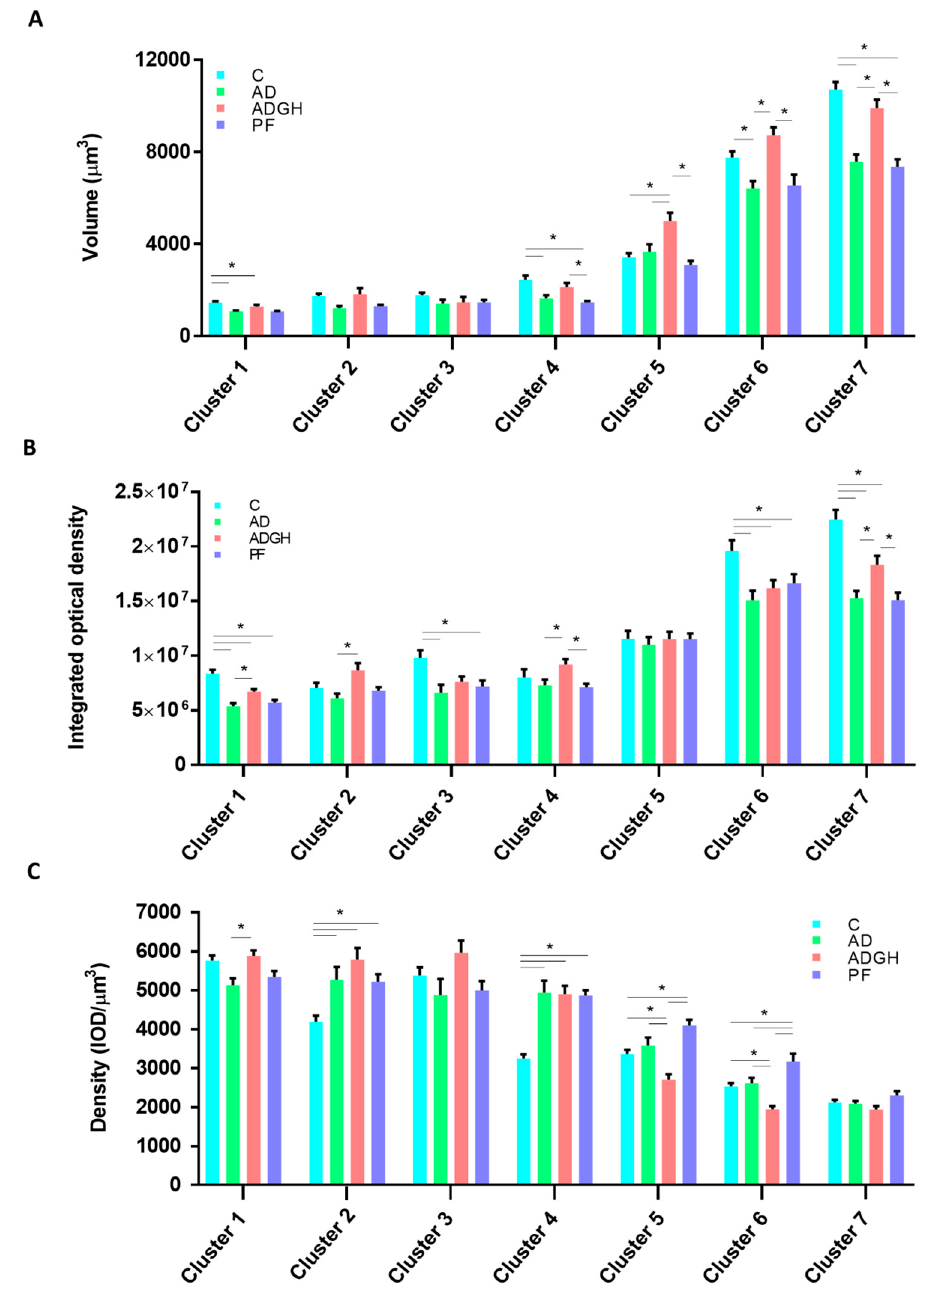
Figure 2. Quantitative values of chondrocytes of the four experimental groups. ( A ) Volume, ( B ) integrated optical density, and ( C ) cytoplasm density of chondrocytes of the groups organized into the seven categories of chondrocytes. Data obtained from a total of 1500 chondrocytes measured. C, control rats; AD, adenine 0.5% rats; ADGH, adenine 0.5% rats treated with GH; PF, pair-fed rats; IOD, integrated optical density. Values are mean ± SEM. * p value < 0.05.